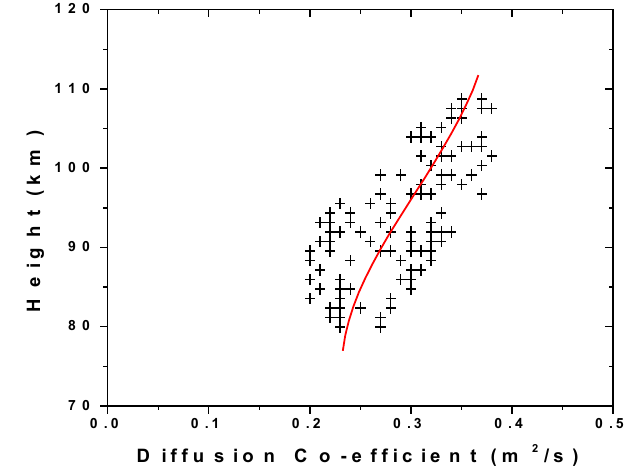
Fig. 9. Scatter plot of Diffusion Coefficient during Leonid Meteor Shower (LMS on 17–18 November) with